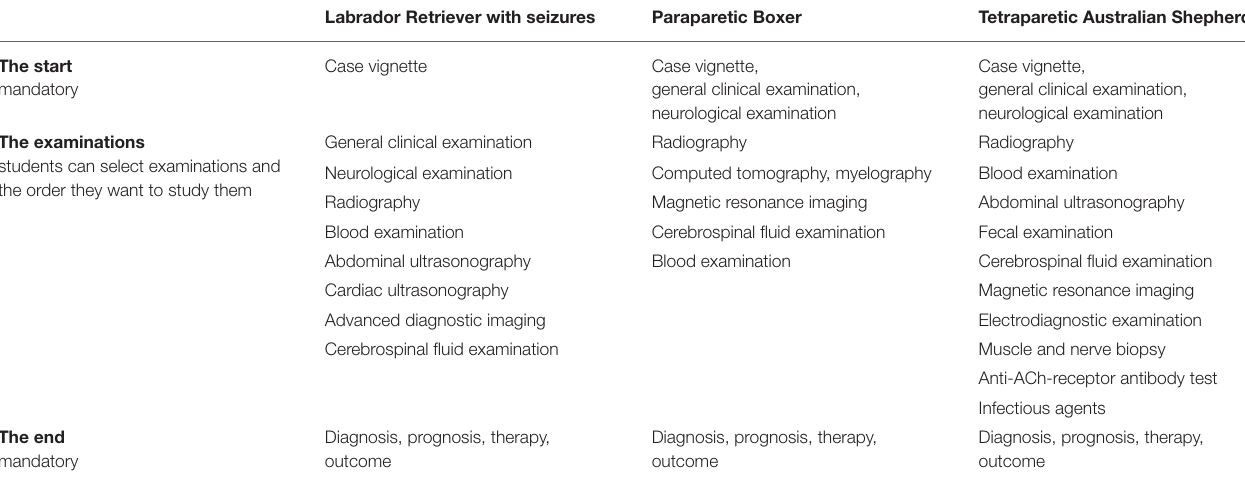
TABLE 1 | Different sections in each bound.